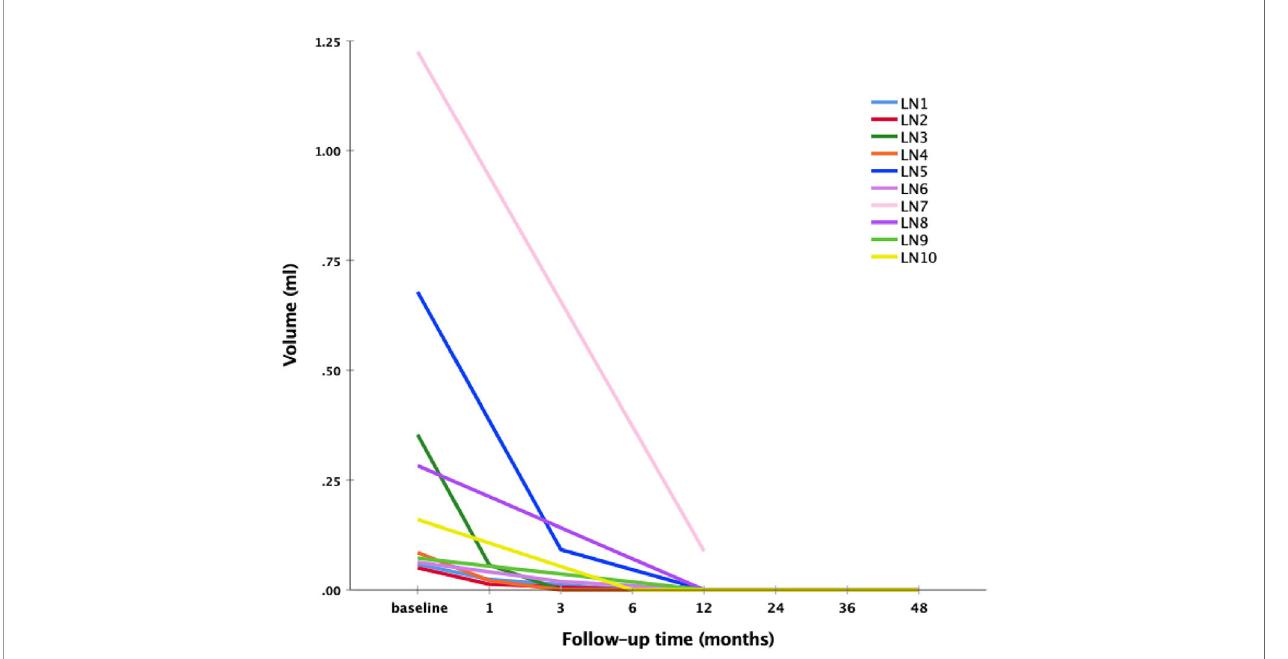
FIGURE 1 | The volume changes of ablated LN after RFA at follow-up.